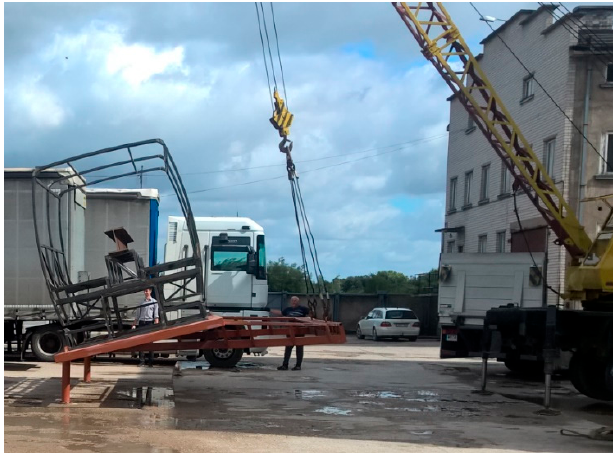
Figure 11. The safety frame before the natural rollover experiment.